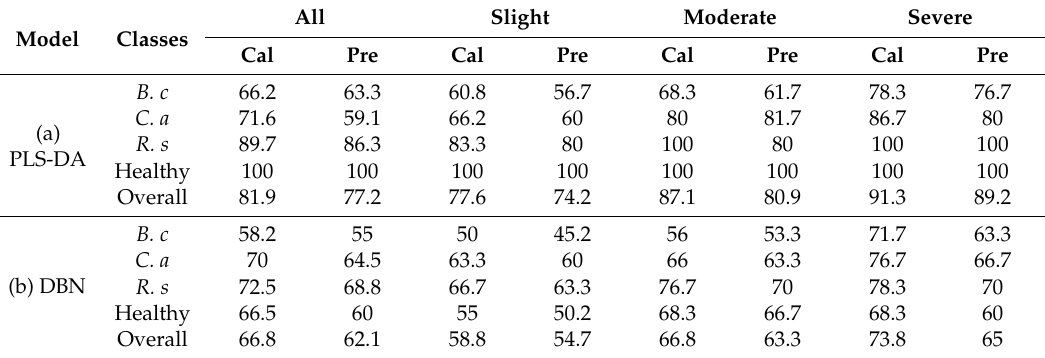
Table 4. Classification results of three fungal diseases in peaches by PLS-DA and DBN models at different decay levels based on optimal spectral and image